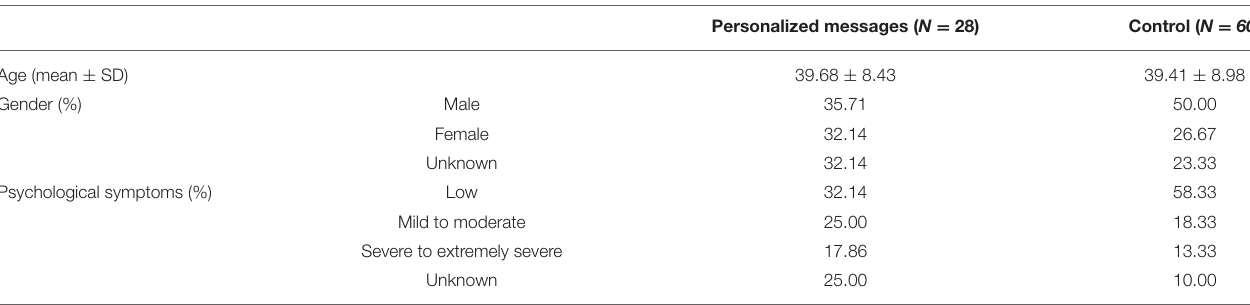
TABLE 1 | Participant characteristics.